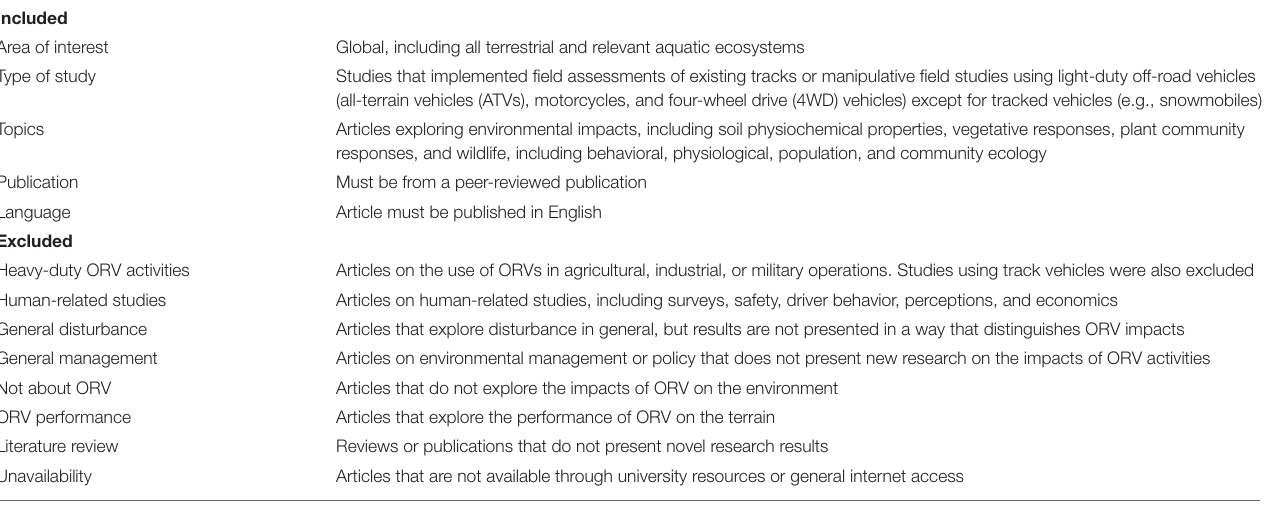
TABLE 2 | Guidelines for inclusion or exclusion from systematic